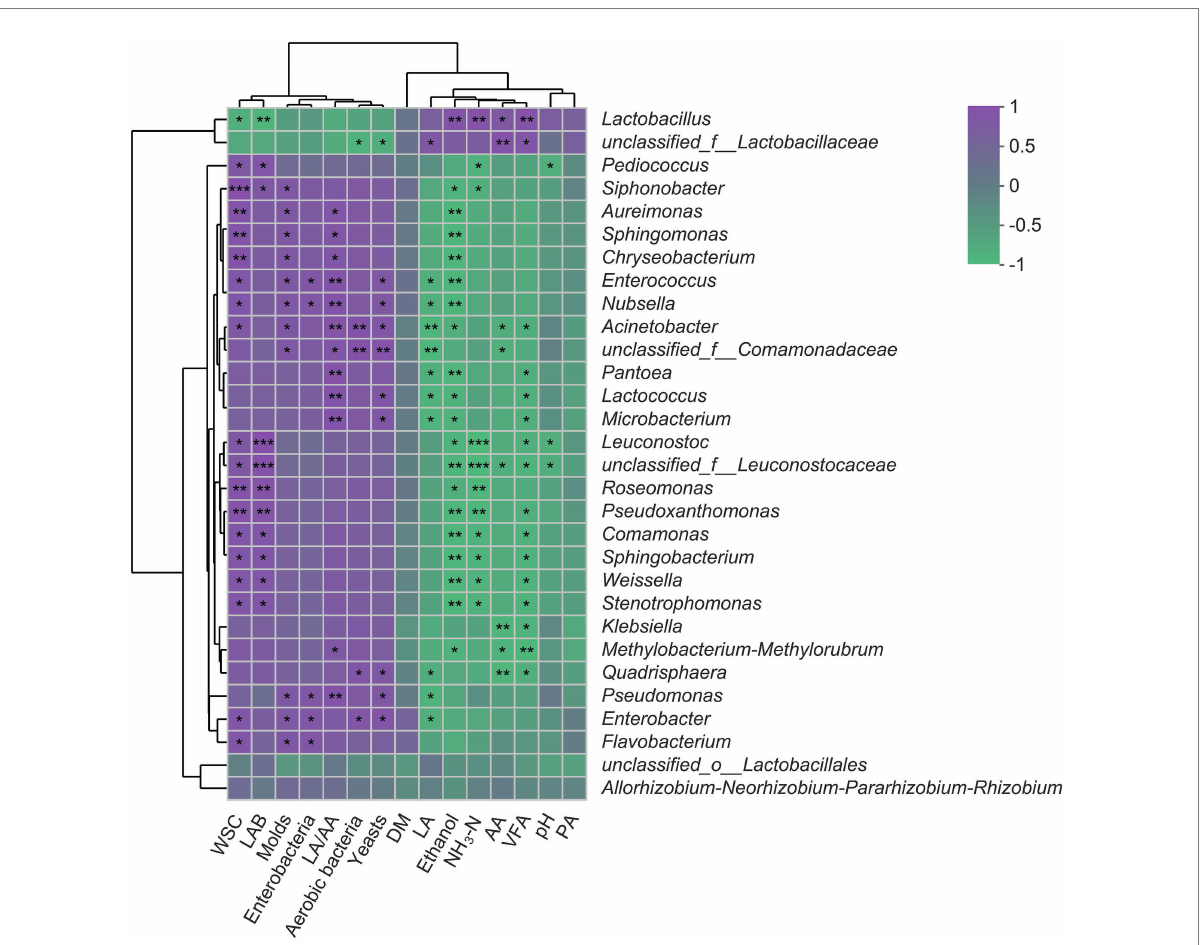
FIGURE 4 Spearman’s correlation heatmap of fermentation parameters and top 30 genera in SSS. Purple squares refer to positive correlation (0 < r < 1), whereas green squares refer to negative correlation ( − 1 < R < 0). * p < 0.05; **0.001 < p ≤ 0.01; *** p ≤ 0.001. WSC, water-soluble carbohydrates; LAB, lactic acid bacteria; LA/AA, the ratio of lactic to acetic acid; DM, dry matter; LA, lactic acid; NH 3 -N, ammonia nitrogen; AA, acetic acid; VFA, volatile fatty acid; PA, propionic